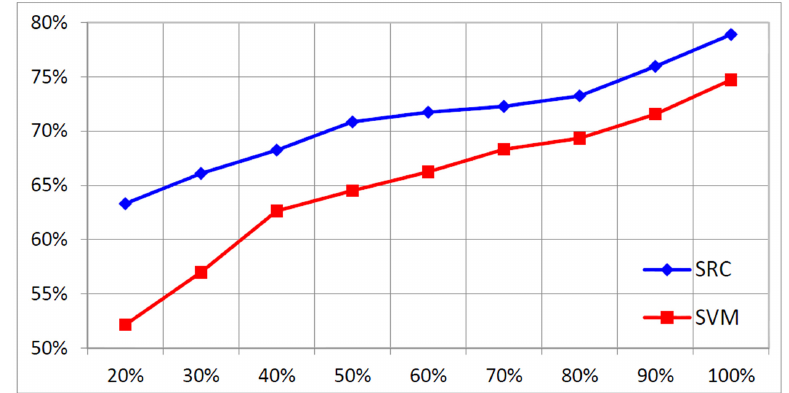
Figure 6. The recognition rates under different percentages of training samples. The horizontal coordinate stands for the percentage of training samples, and the vertical coordinate represents the recognition accuracy.